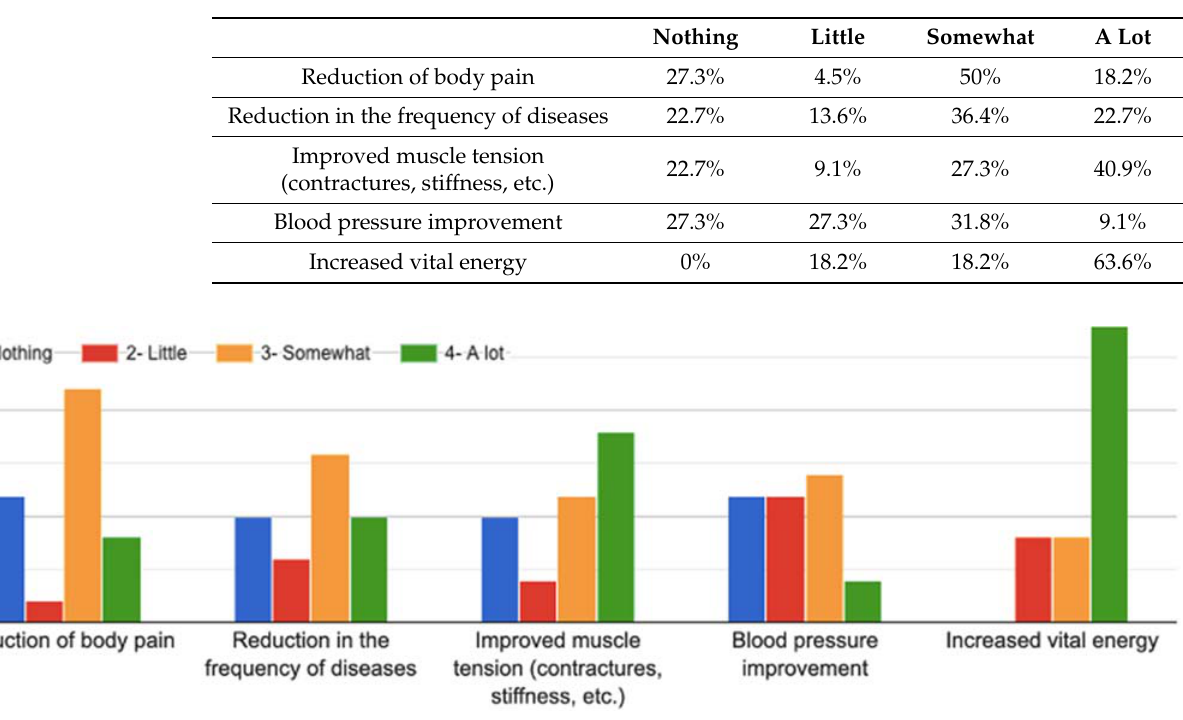
Figure 5. Degree of incidence in the physical health aspects improved by the practice of mindful ‐